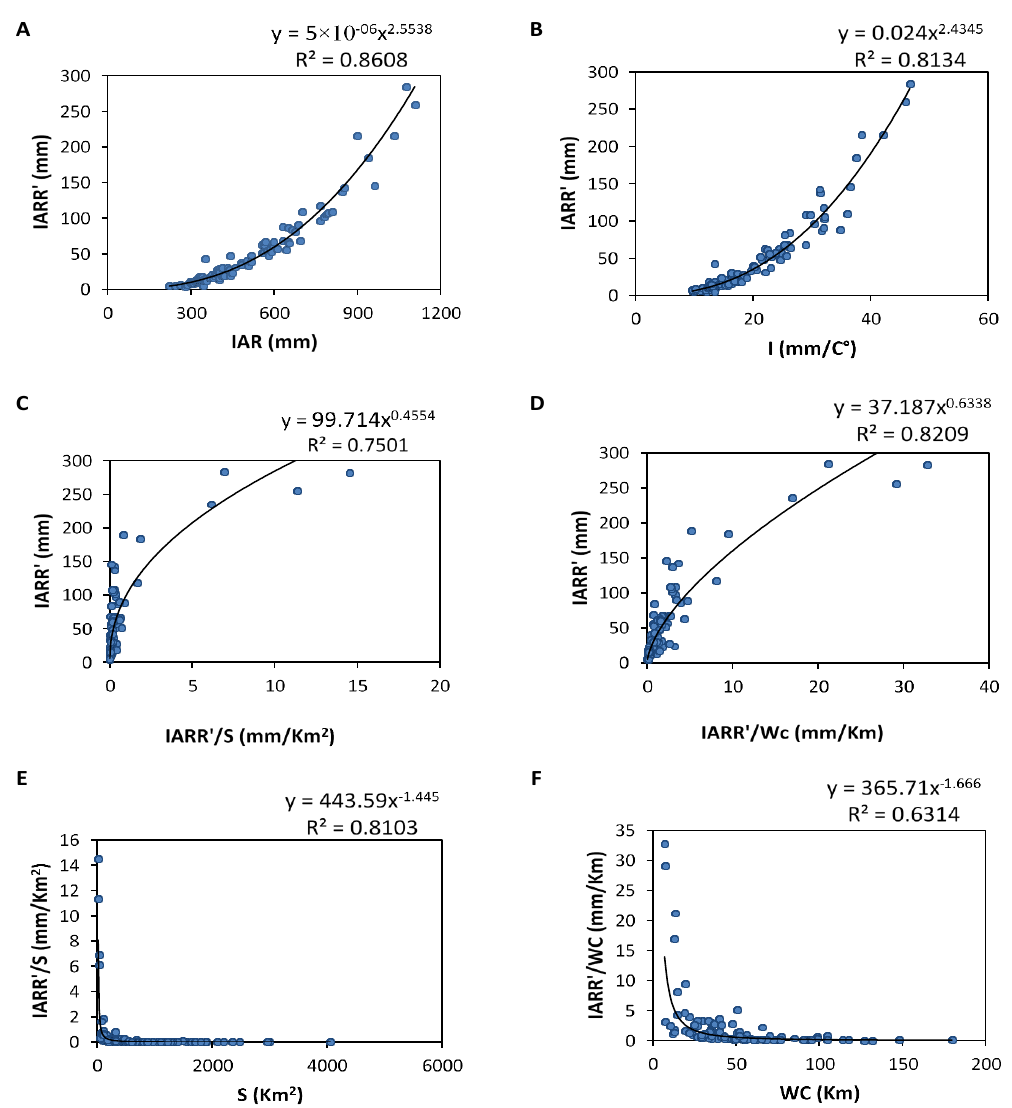
Figure 5. Nonlinear regression curve between inter-annual rainfall-runoff residuals data obtained by Ol’Dekop’s model (IARR’) and ANN S input variables which are ( A ) Inter-annual rainfall (IAR); ( B ) De martone index (I); ( C , E ) watershed area (S); ( D , F ) watercourse (WC).